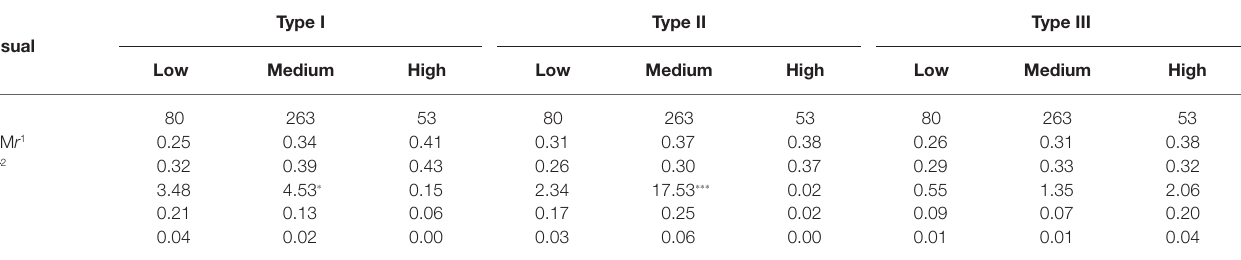
TABLE 10 | Differences in learning outcomes (relative values) between multimedia (MM r ) and text (T r ) for the three instruments for verbal channel capacity.